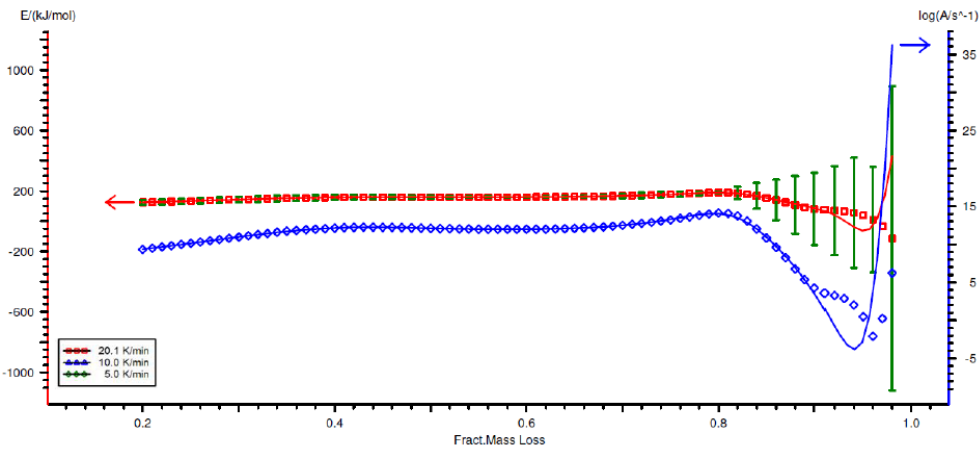
Figure 8. Activation energy and pre-exponential coefficient as a function of Ozawa–Flynn–Walla conversion for a maize straw sample. Table 1. Activation energy and pre-exponential coefficient as a function of the degree of conversion by the Ozawa–Flynn–Walla method for a maize straw sample.